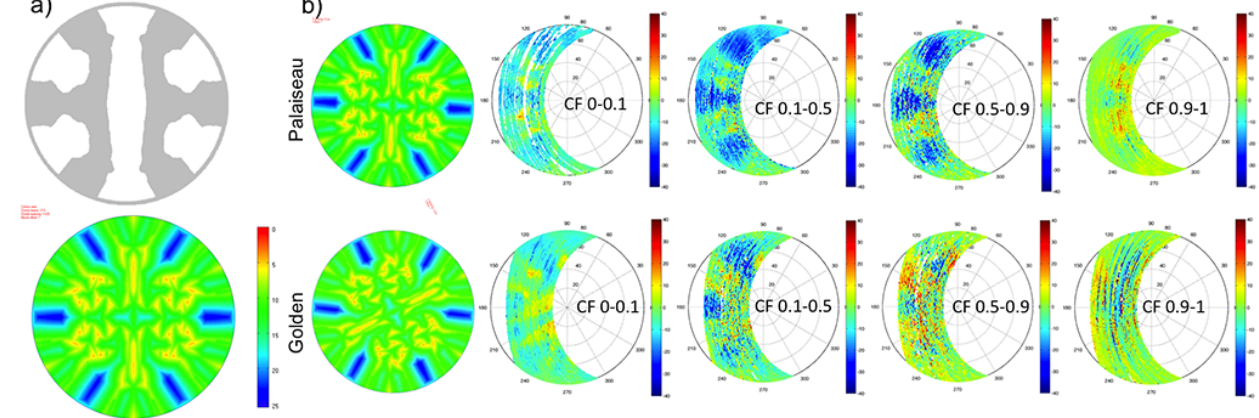
Figure 9. (a) Modelled diffuse first touch angles for the SPN1 relative to the shadow mask. Colour scale gives angle in degrees. (b) DHI differences (TBM – SPN1) in polar coordinates (of SZA and SAA) at Palaiseau and Golden for different bins of CF with the first touch angles pattern rotated for easier visual